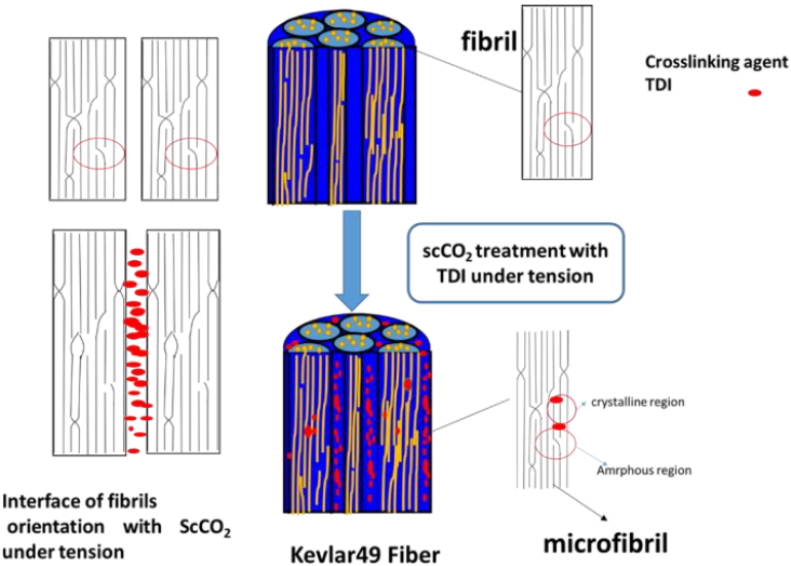
Figure 11. The model of the progress and structure change in scCO 2 with TDI under tension.